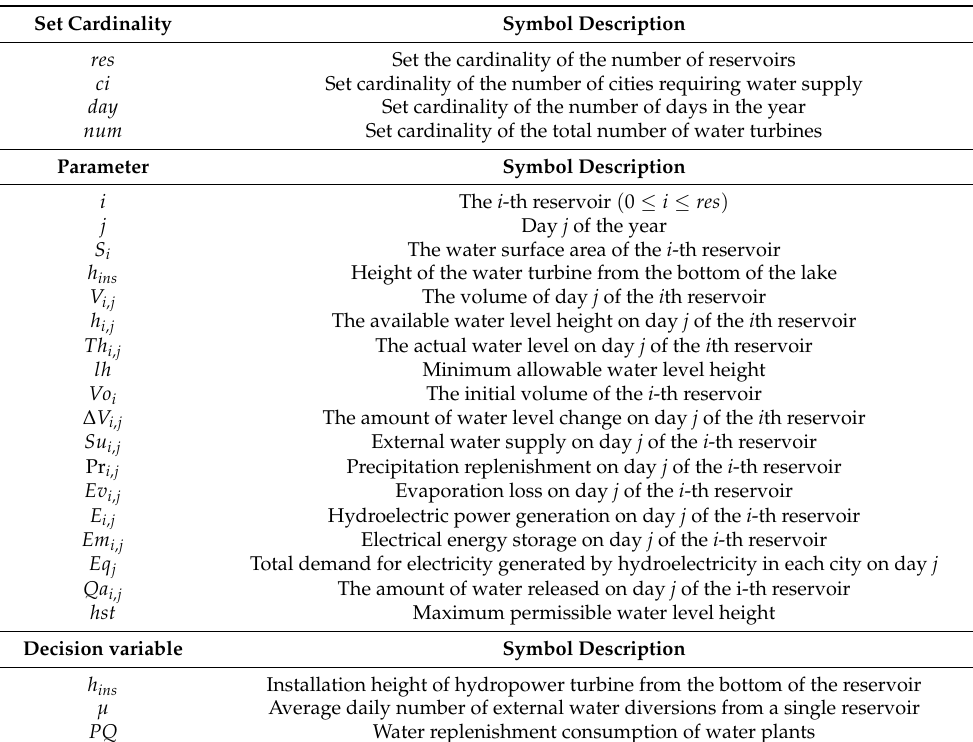
Table 1. Description of the main mathematical